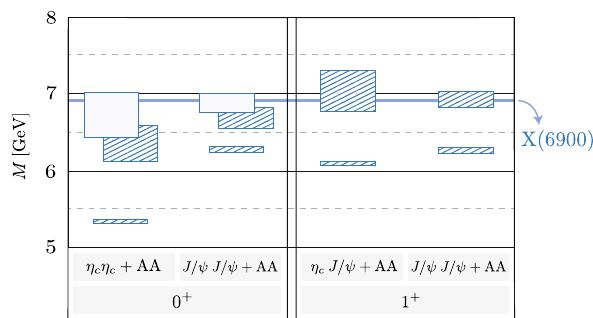
Fig. 4 The all-charm spectrum showed graphically with different quantum numbers 0 + and 1 + , showing the ground states and excited ones. Striped rectangles denote states which are dominated strongly by the meson–meson components, such that diquark–antidiquark com- ponents are completely negligible. In contrast, open rectangles denote states with still dominant meson–meson components, but significant diquark–antidiquark admixtures. The vertical extent of the rectangles denote the numerical error from the extrapolation of the corresponding eigenvalue curve and the continuous, horizontal blue line denotes the experimental value for the X(6900)